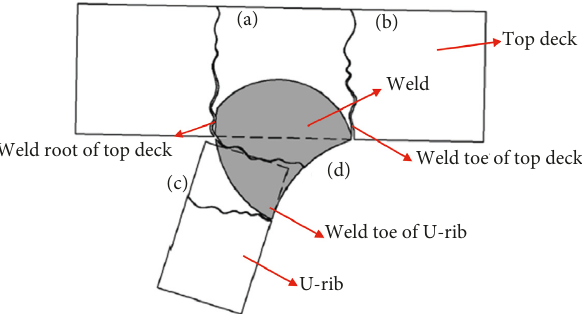
Figure 8: Four types of fatigue cracks in the connection of U-rib stiffened plate and top